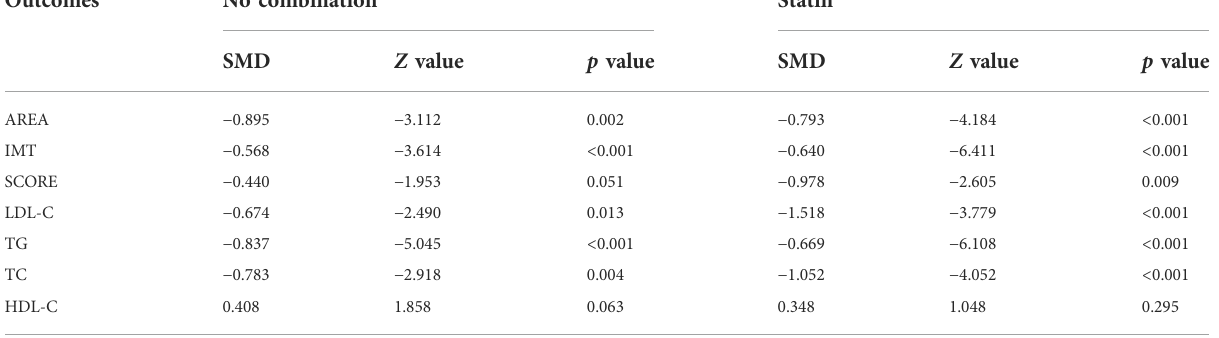
TABLE 7 Subgroup analysis strati fi ed by combination drugs.